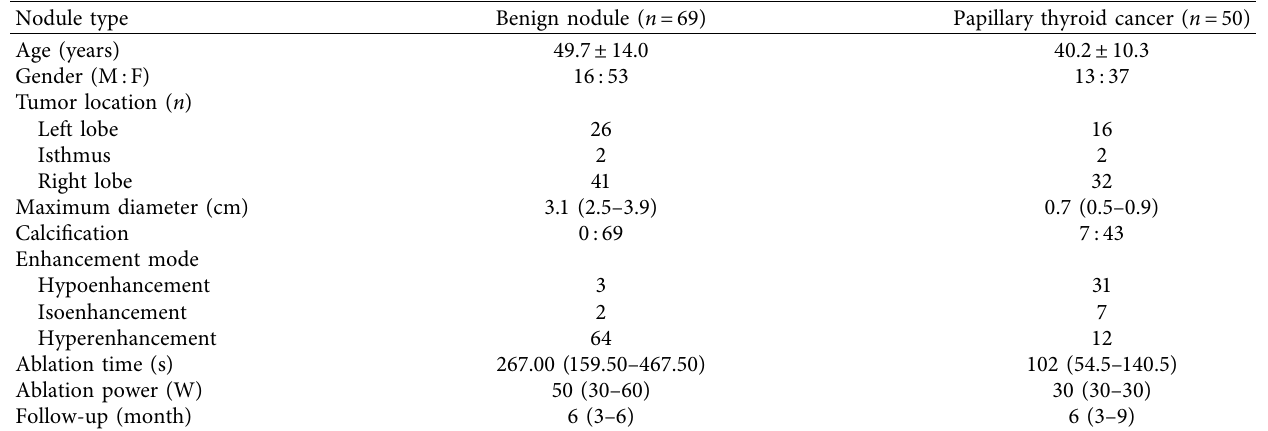
Table 2: Baseline characteristics of the enrolled patients.